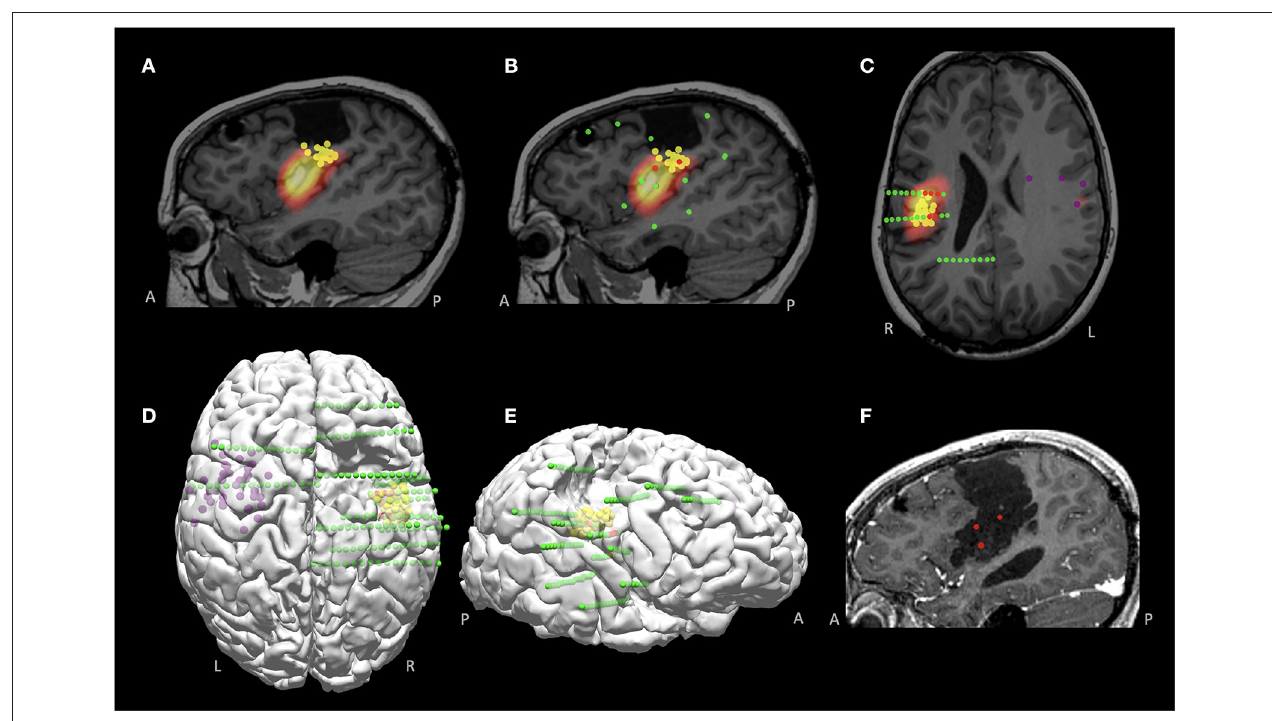
FIGURE 8 | MMII findings in Case 2 with a previously failed epilepsy surgery. (A) Co-localized MEG and SPECT findings, around the inferior margin of the previous resection, shown on the sagittal plane. (B,C) Sagittal and axial views of the SEEG implantation, overlaid with the MEG findings (yellow spheres indicate right-sided tight MEG luster, purple spheres indicate left-sided loose MEG cluster). Green spheres indicate all implanted electrodes and red spheres indicate ictal onset, which was highly concordant with the co-localized MEG and SPECT region. (D,E) 3D views (top view and right-sided view) of the findings from MEG and SEEG, visualizing the spatial relationship with the prior resection. (F) Post-operative MRI after the re-operation, showing extension of the prior resection, including the SEEG ictal onset and the co-localized MEG and SPECT region. The patient became seizure-free at the most recent 1-year follow up, without new neurological deficits. Histopathology showed remote ischemic